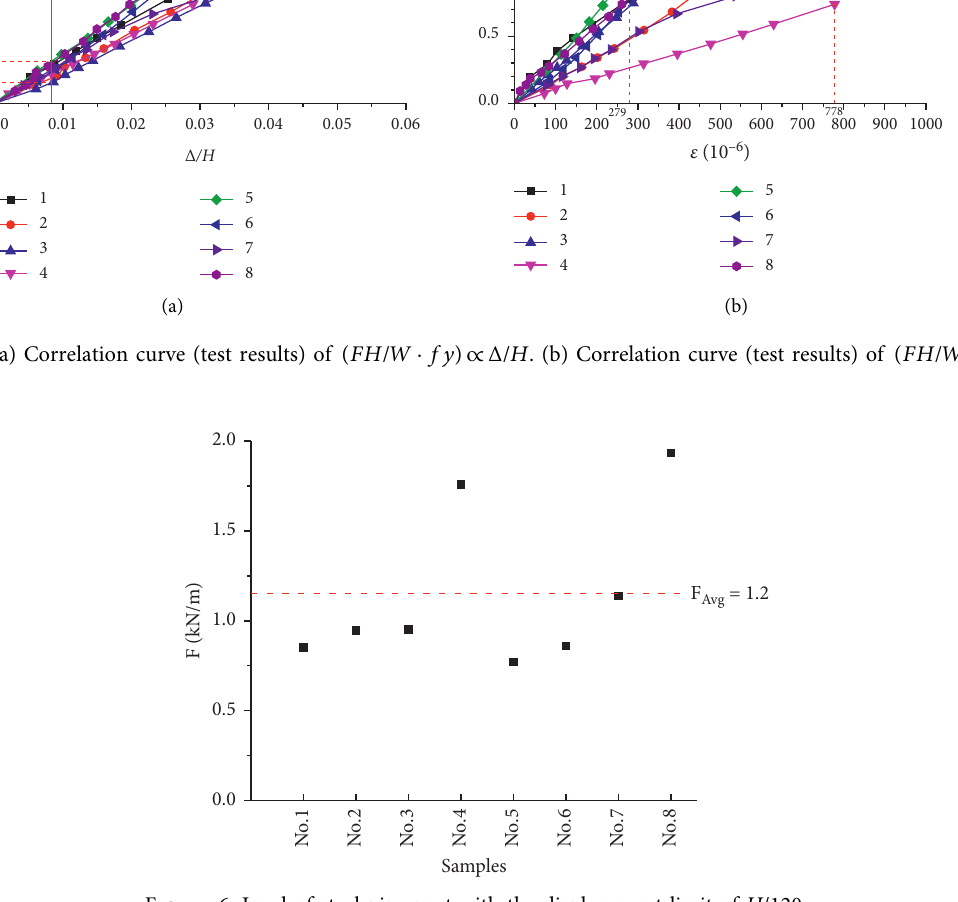
Figure 6: Load of steel pipe post with the displacement limit of H /120.